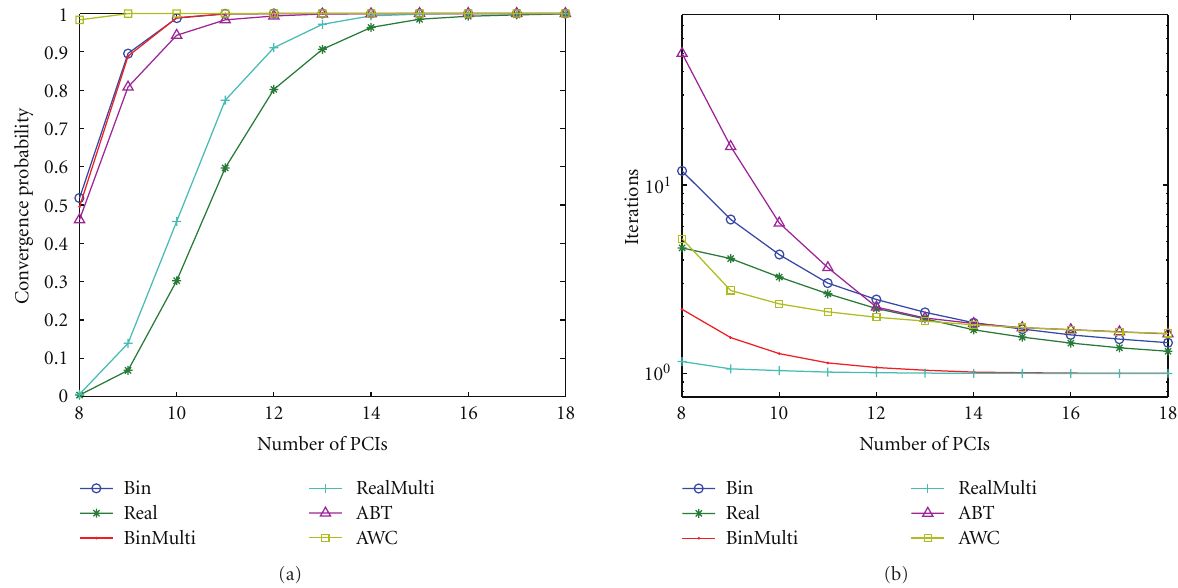
Figure 5: Convergence properties versus number of PCIs for di ff erent autonomous PCI configuration algorithms. (a) Convergence probability. (b) Average number of iterations (only converged drops considered).